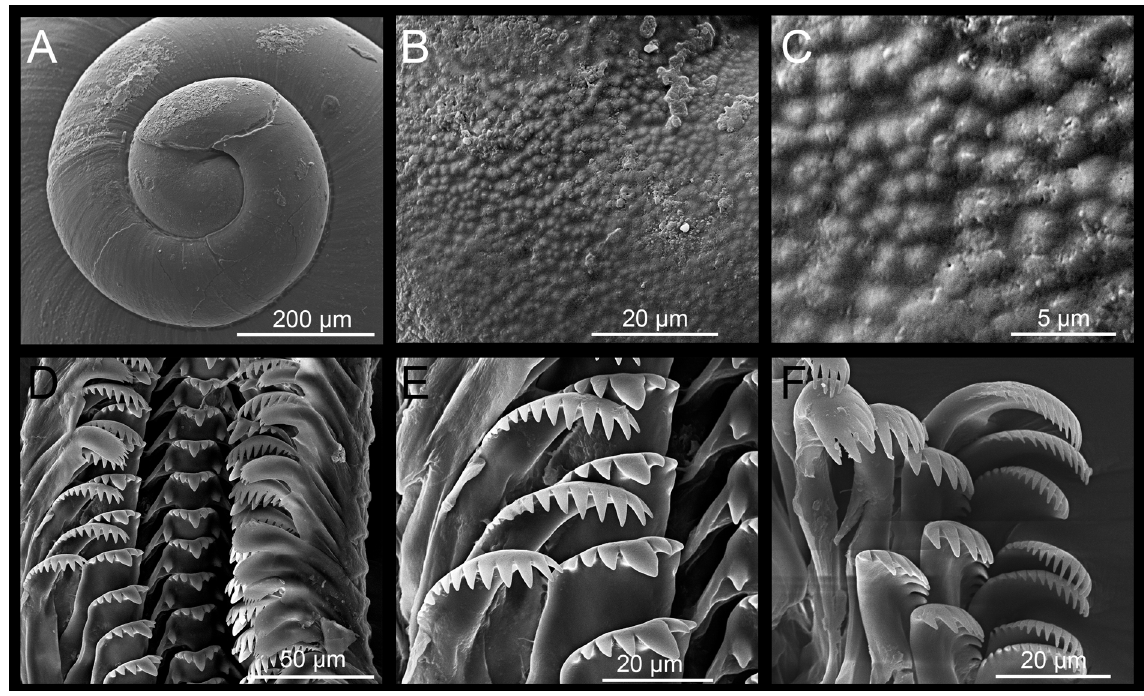
Fig. 16. Protoconch (A–C) and radula (D–F) of Mercuria maceana (Paladilhe, 1869) from C’an Tunis, Barcelona, Spain. A . Protoconch nucleus. B . Details of the protoconch. C . Protoconch microsculpture. D . Overview of radular teeth rows. E–F . Detailed view of the lateral and inner